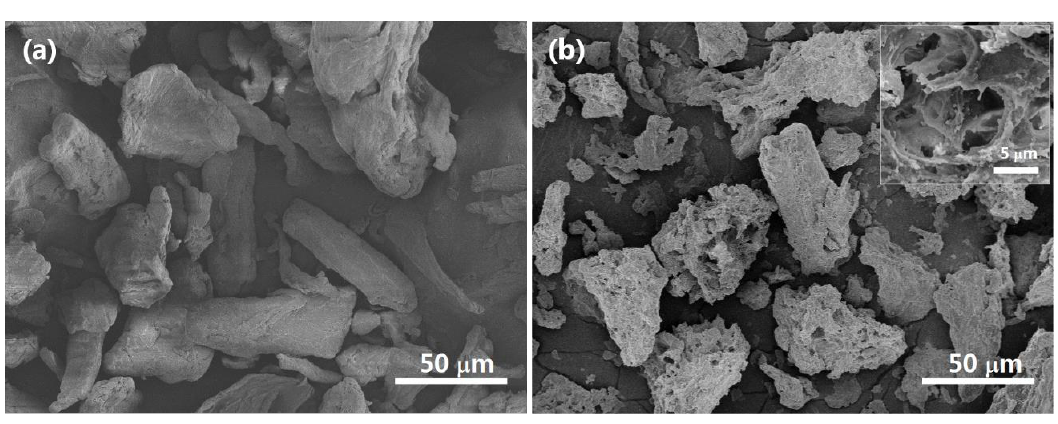
Figure 1. SEM images of the pristine ( a ) and urea-terminated silane-modified ( b ) cellulose particles.